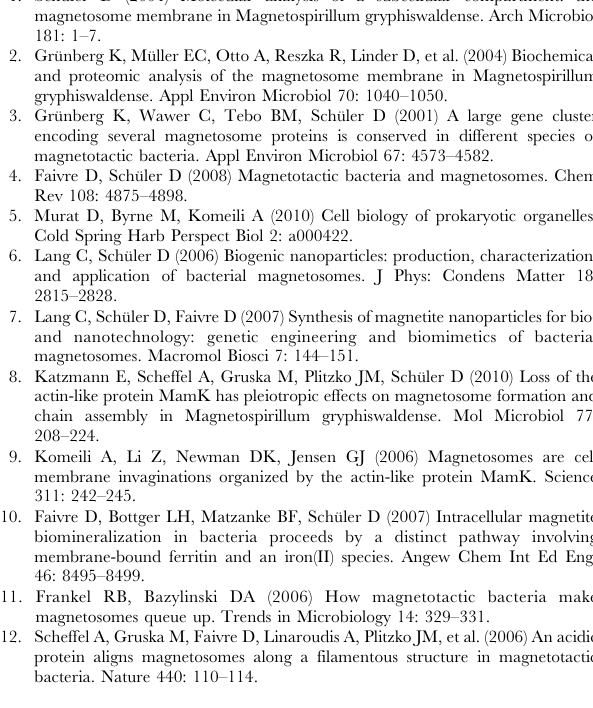
Figure S1 Schematic illustration of methods for gener- ation of deletions within the MAI. (A) Allelic replacement of target genes using double cross-over followed by removal of selection marker with Cre- lox mediated excision. (B) Cre- lox recombination using the modified sequences lox71 and lox66 for specific excision of large chromosomal regions and construction of